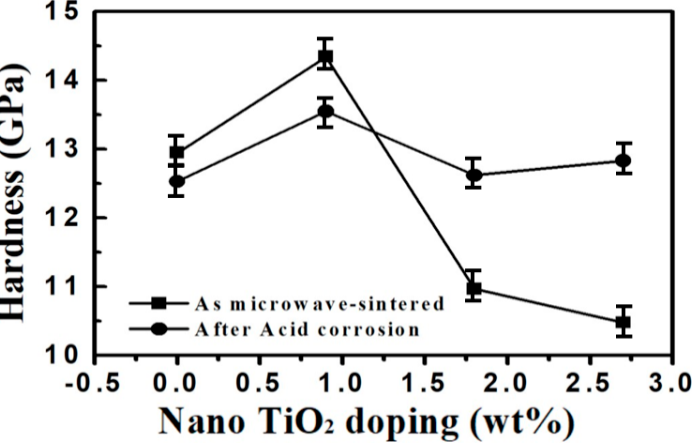
Figure 7. Vickers hardness of the 3Y-TZP ceramics as a function of 0, 0.9, 1.8, and 2.7 wt% nano TiO 2 contents under as-sintering and after citric acid corrosion treatment.